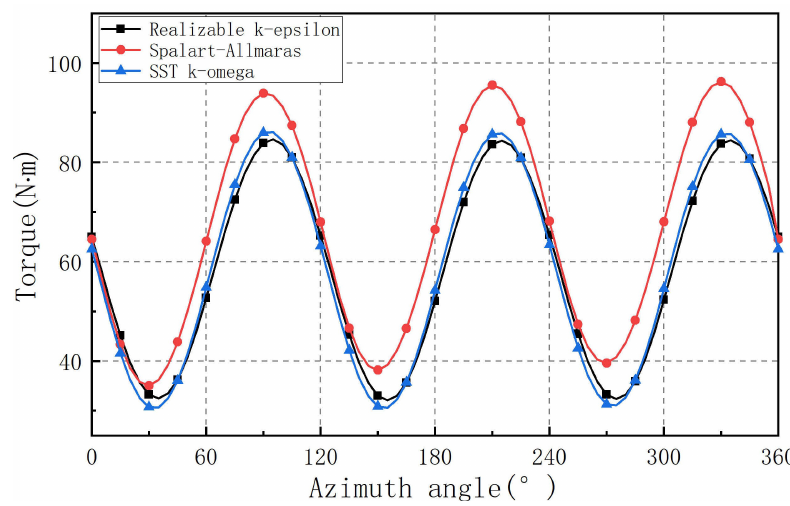
Figure 15. Torque curves of offshore wind turbine under different turbulence